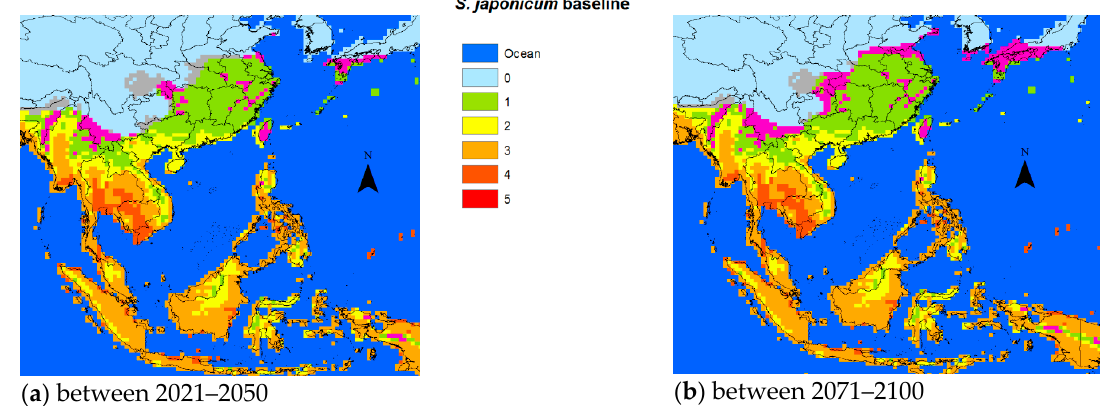
Figure 2. Change of risk area for S. japonicum vs. the baseline. a ) 2021–2050 vs. the baseline, b ) 2071– 2050 vs. the baseline.